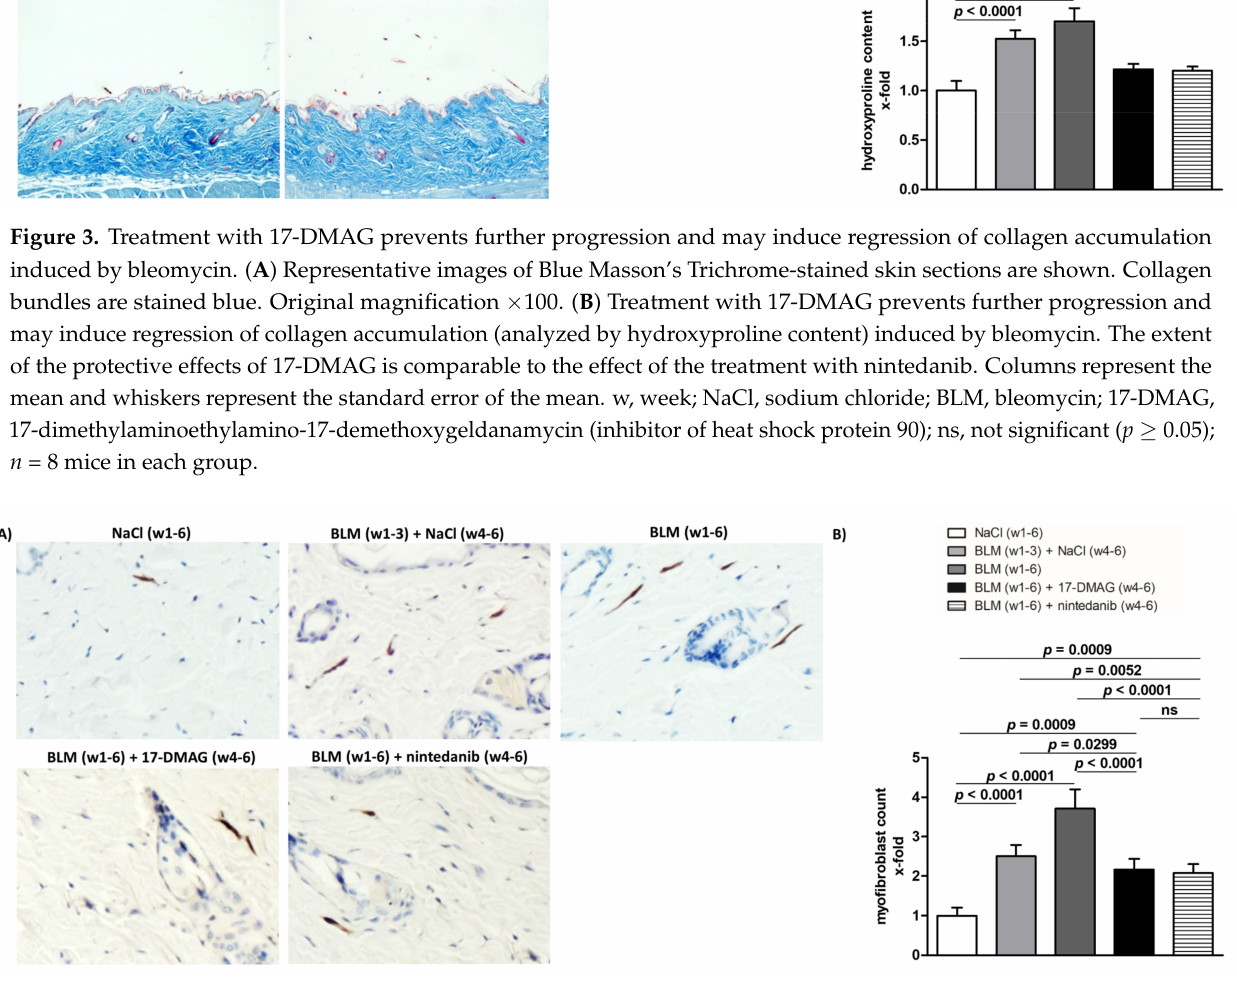
Figure 4. Treatment with 17-DMAG prevents further progression and may induce regression of proliferation of myofibrob- lasts induced by bleomycin. ( A ) Representative images of α -smooth muscle actin (aSMA)-stained skin sections are shown. aSMA-positive cells are stained brown, nuclei are counterstained blue by hematoxylin. Original magnification × 400. ( B ) Treatment with 17-DMAG prevents further progression and may induce regression of the proliferation of myofibroblasts induced by bleomycin. The extent of the protective effects of 17-DMAG is comparable to the effect of the treatment with nintedanib. Columns represent the mean and whiskers represent the standard error of the mean. w, week; NaCl, sodium chloride; BLM, bleomycin; 17-DMAG, 17-dimethylaminoethylamino-17-demethoxy-geldanamycin (inhibitor of heat shock protein 90); ns, not significant ( p ≥ 0.05); n = 8 mice in each